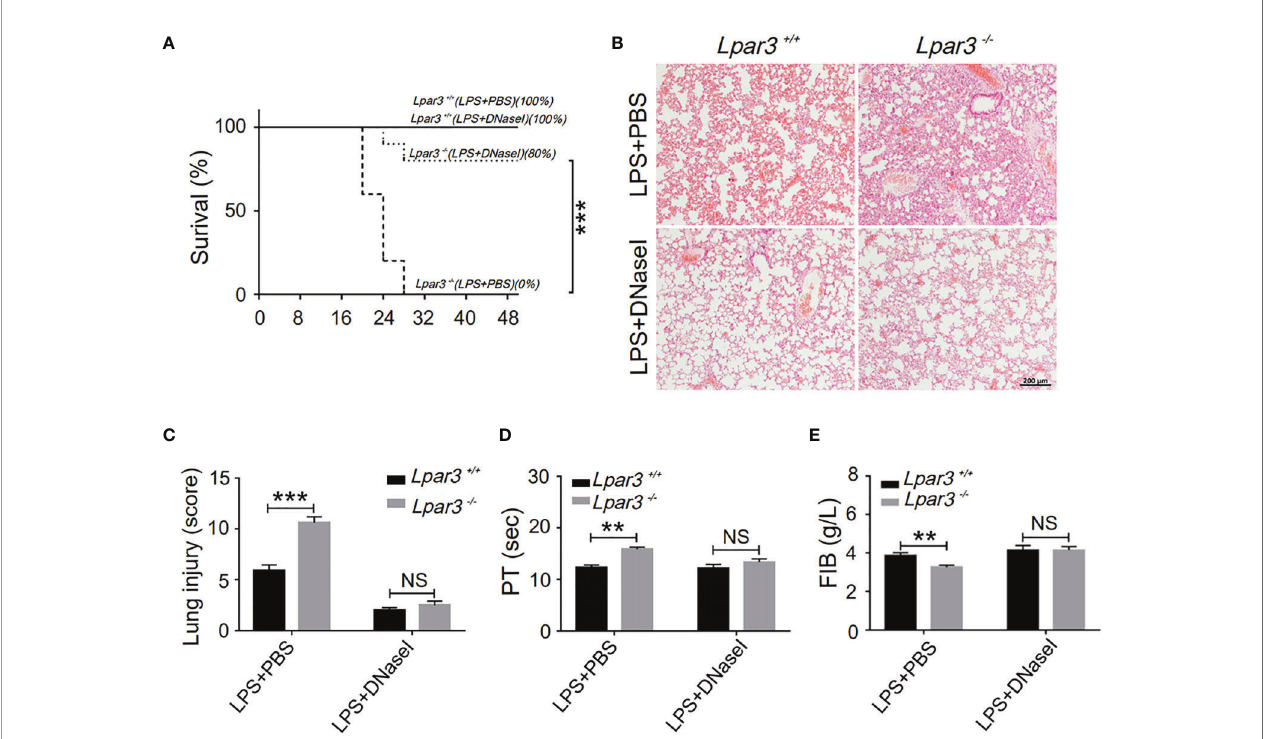
FIGURE 4 | NETs scavenger DNaseI reduces organ damage and coagulation irregularities in sepsis (A), The survival rate of septic mice with DNaseI. WT and Lpar3 -/ - septic mice intravenously injected with PBS or DNaseI, monitored every 4 h for a 48-h period, and DNaseI-treated Lpar3 -/- septic mice showed a higher survival rate than PBS-treated Lpar3 -/- septic mice (n = 10 for each group); (B, C), H&E staining of the lungs of PBS-treated or DNaseI-treated mice. DNaseI-treated Lpar3 -/- septic mice showed less lung damage compared with PBS-injected Lpar3 -/- controls; the individuals who graded the severity of lung injury were blinded to the genotype (n = 8 for each group). (D, E), The circulating levels of coagulation markers PT and FIB in the PBS-treated or DNaseI-treated septic mice (n = 5 for each group). **P < 0.01, ***P < 0.0001. NS, no signi fi cance. LPA 3 , lysophosphatidic acid receptor 3; WT, wild-type; PBS phosphate-buffered saline; LPS, lipopolysaccharide; H&E, hematoxylin and eosin; NETs, neutrophil extracellular traps; DNase I, deoxyribonuclease